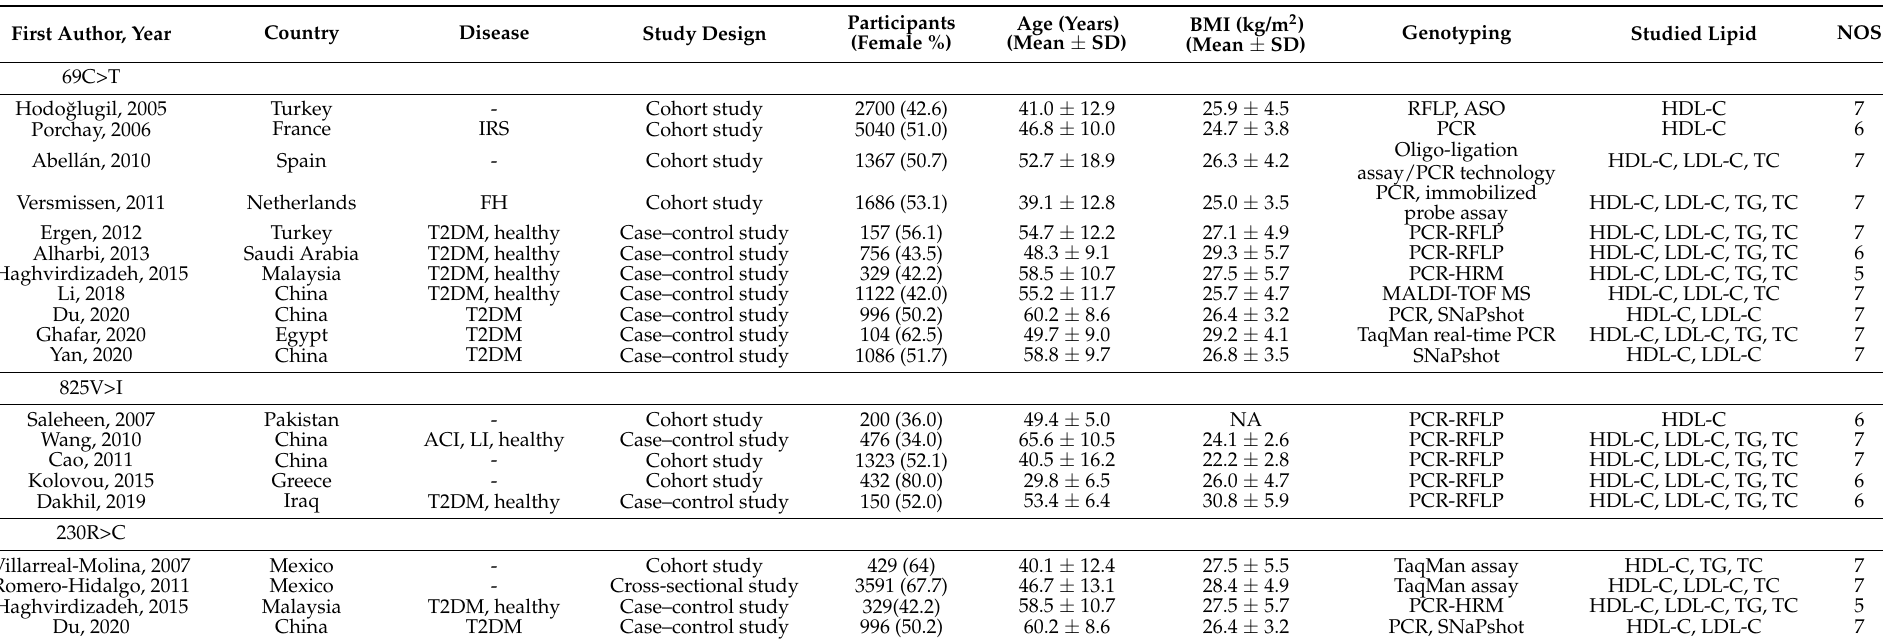
Table 1. Characteristics of ABCA1 69C>T, 825V>I, and 230R>C studies included in the systematic